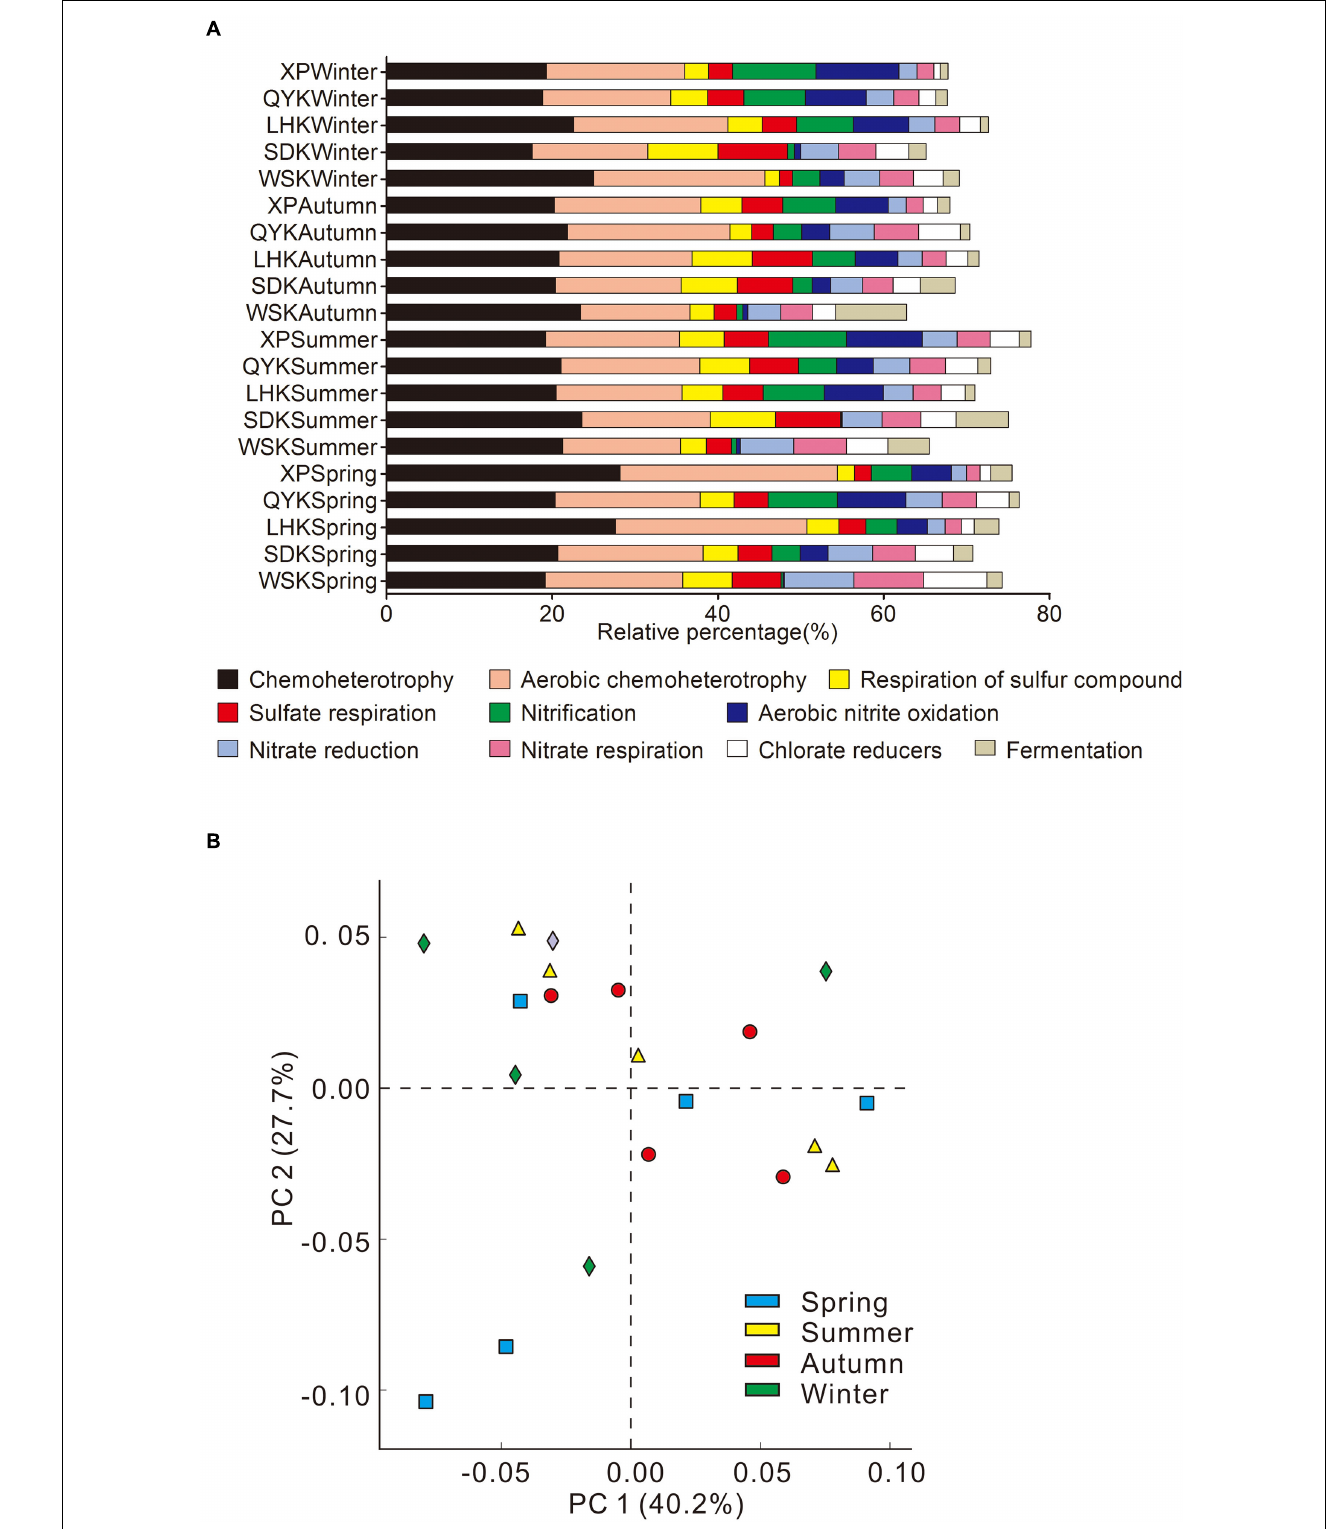
FIGURE 7 | Summary of major ecological functions (A) and principal component analysis (PCA) of ecological functions (B) contributed by microbial communities in the intertidal sediments of Yangtze River estuary, among different seasons (Kruskal-Wallis H-test).